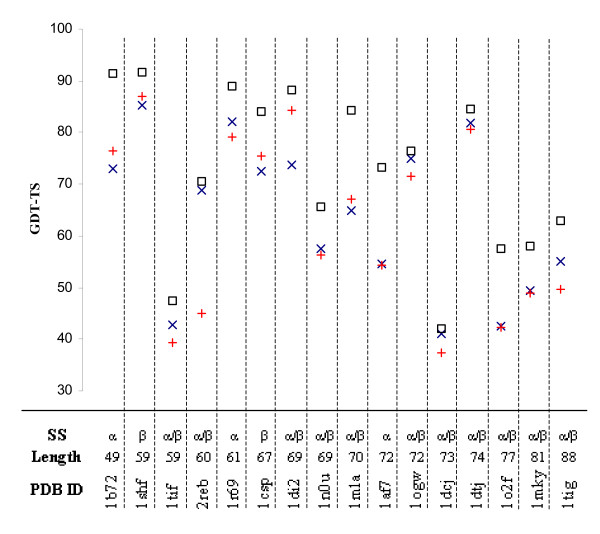
Large Decoy Set Model Selection. Large decoy set model selection with SELECTpro on I-TASSER benchmark set. This set of 16 small proteins was used as one of the benchmark sets for evaluating the I-TASSER method [19]. The complete decoy sets can be downloaded from [20]. Each protein has from 12500 to 20000 decoy models. For each protein different symbols are used to indicate the GDT-TS of Mmax (□), SELECTpro's MQA1 (×), and I-TASSER's MQA1 (+).